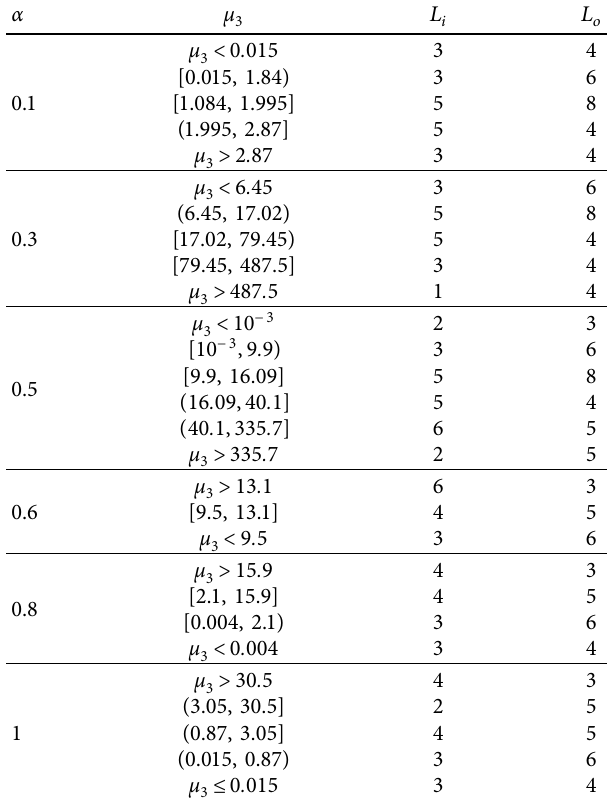
Table 1: Equilibrium solutions in case I, where L lutions that are inside the kite, and L o represents solutions that are outside the